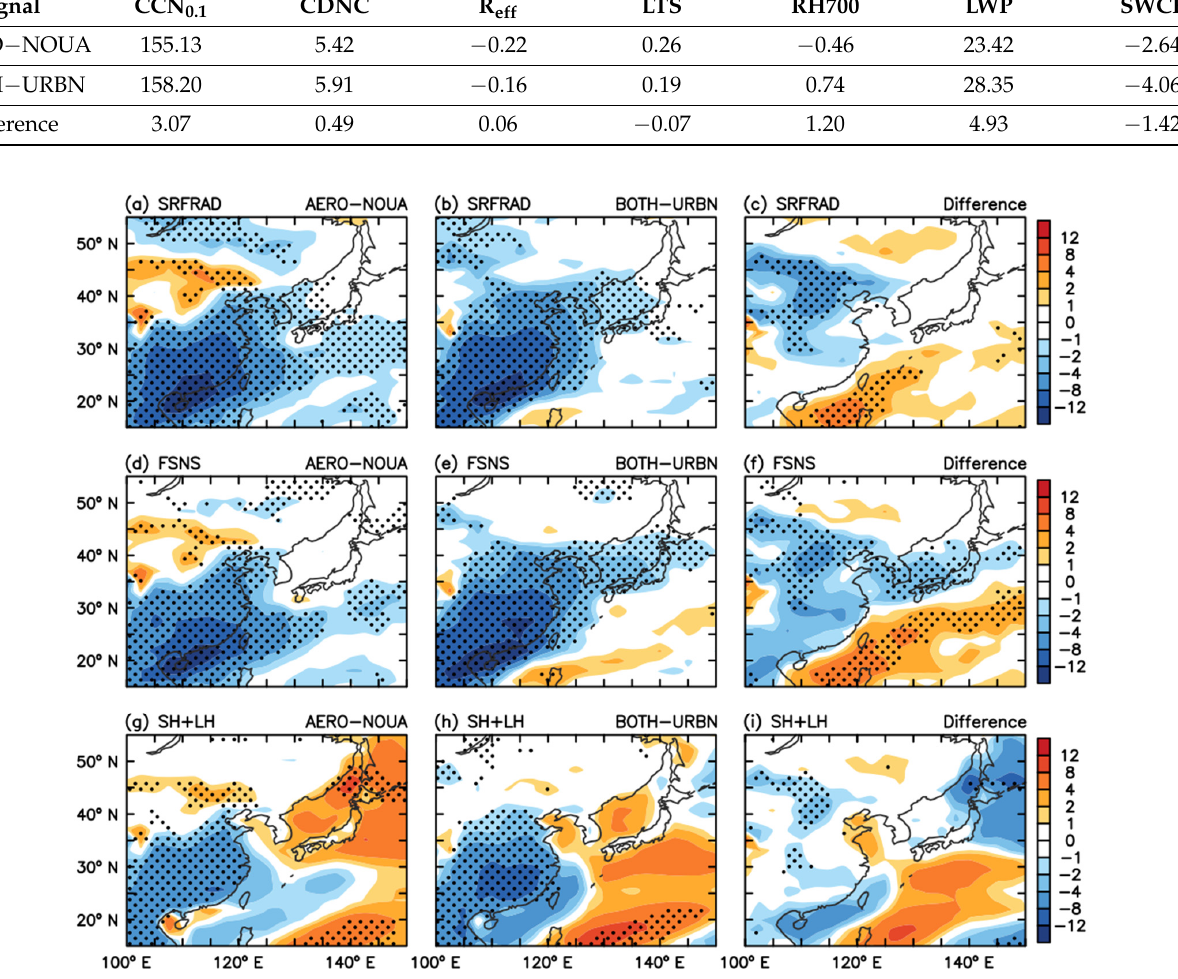
Figure 9. Same as Figure 5, but for ( a – c ) the surface net radiation flux (positive downward; in W/m 2 ), ( d – f ) surface net shortwave flux (positive downward; in W/m 2 ), and ( g – i ) turbulent (sensible + latent) heat fluxes (positive upward; in W/m 2 ).